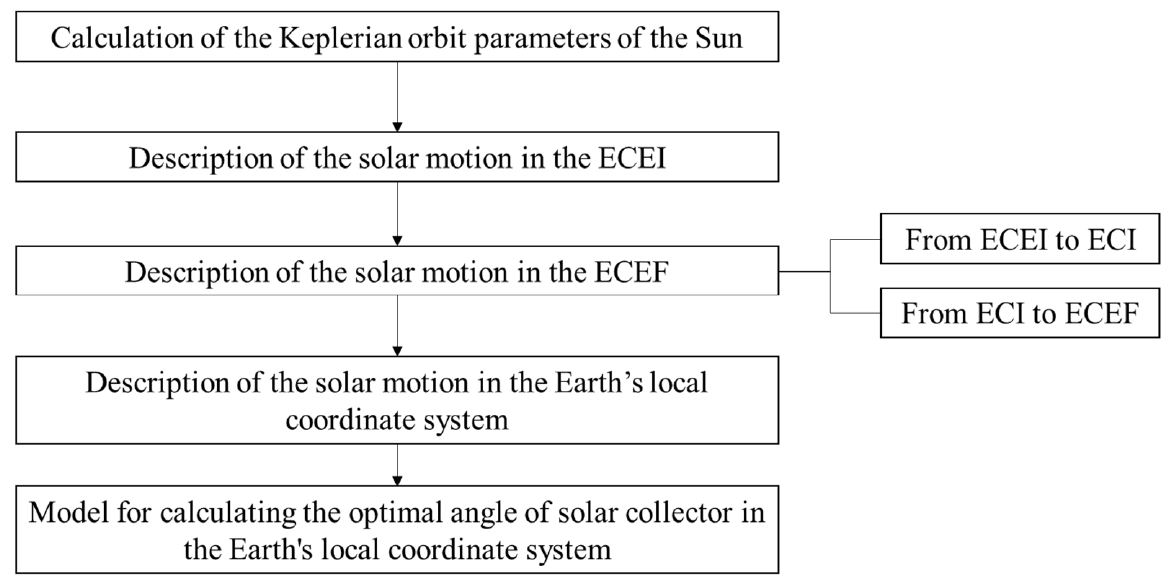
Figure 3. A visual flowchart of the calculation used to describe the orbital motion of the Sun from the Earth’s local coordinate system. ECEI: Earth-centered ecliptic inertial; ECEF: Earth-centered, Earth-fixed; ECI: Earth-centered inertial.